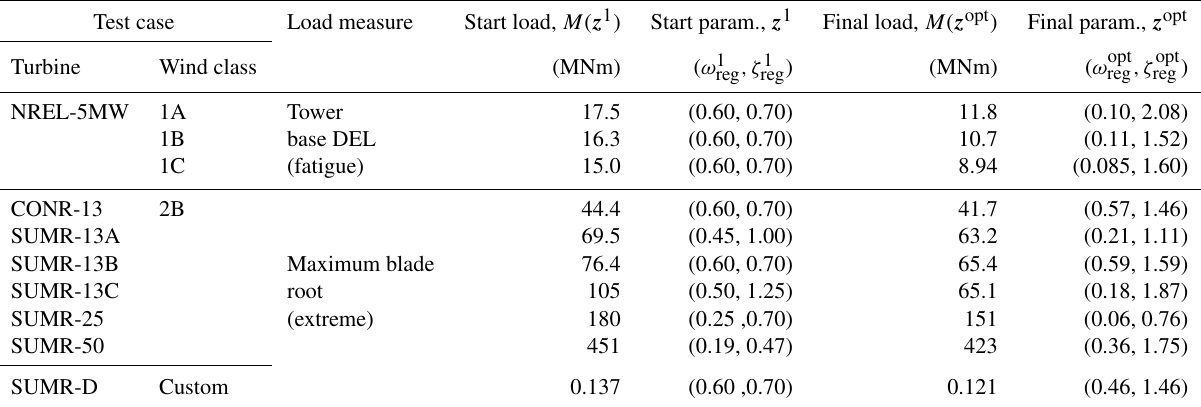
Table 3. Summary of test cases and results from a single zeroth-order parameter tuning for speed regulation control using the parameters in Table 2 with N stage = 7 and J =